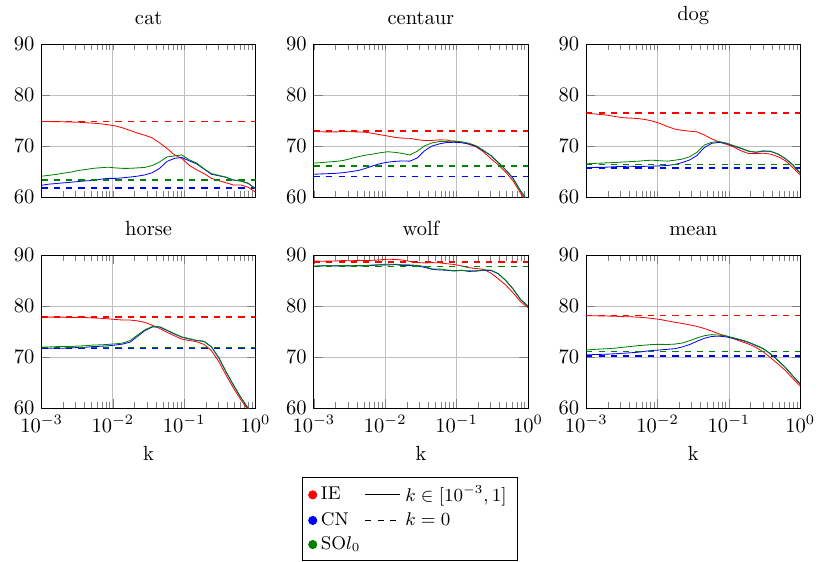
Figure 9. We plotted the hit rate at a geodesic error of 0.25 over the damping parameter k . With the three different colours, we identify the numerical schemes that were used to solve the damped wave equation on the different shapes. Red indicate the IE scheme, blue denotes the CN method, and green stands for the SO l 0 scheme. Solid lines denote a changing damping parameter k , and the dashed lines indicate a fixed k = 0.